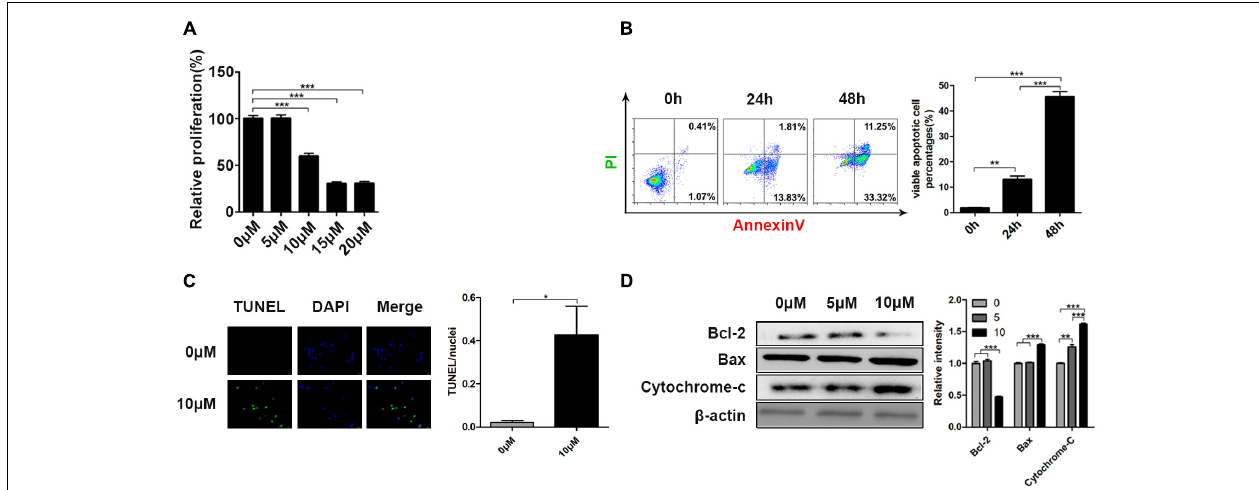
FIGURE 1 | Curcumin reduced cell viability and induced cell apoptosis in H446 human SCLS cell line. (A) The relative proliferation of H446 cells was determined after 24 h curcumin treatment at different concentration (0, 5, 10, 15, 20 µ M). (B) The apoptosis rate of H446 cells was evaluated by Annexin-V/PI apoptosis detection kit after 24 and 48 h curcumin (10 µ M) treatment. The quantitative apoptotic percentages were shown. (C) After 24 h exposure to curcumin (10 µ M), the apoptotic cells were identified by TUNEL apoptosis assay kit. (D) Expression of apoptosis-related proteins including Bcl-2, Bax, and cytochrome-C was detected after treatment of curcumin (0, 5, 10 µ M) for 24 h. Data are showed as mean ± SEM ( n = 3); ** P < 0.01, *** P < 0.005.